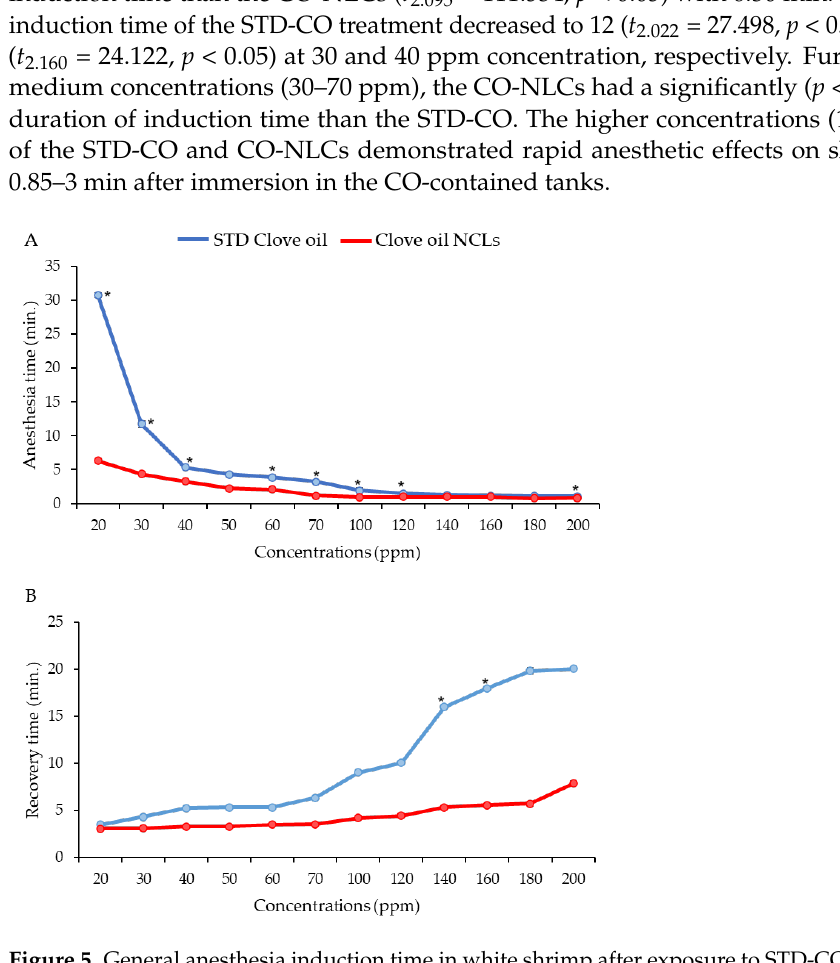
Figure 5. General anesthesia induction time in white shrimp after exposure to STD-CO and CO-NLCs ( A ). Recovery time from general anesthesia in the anesthetized white shrimp induced by STD-CO and CO-NLCs ( B ). (*) indicates a significant difference ( t -test, p < 0.05) between STD-CO and CO-NLCs for the particular concentration.